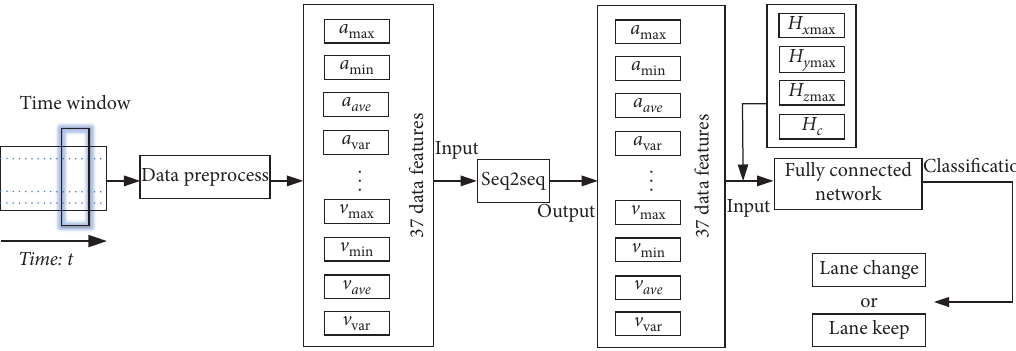
Figure 6: Data processing procedure.